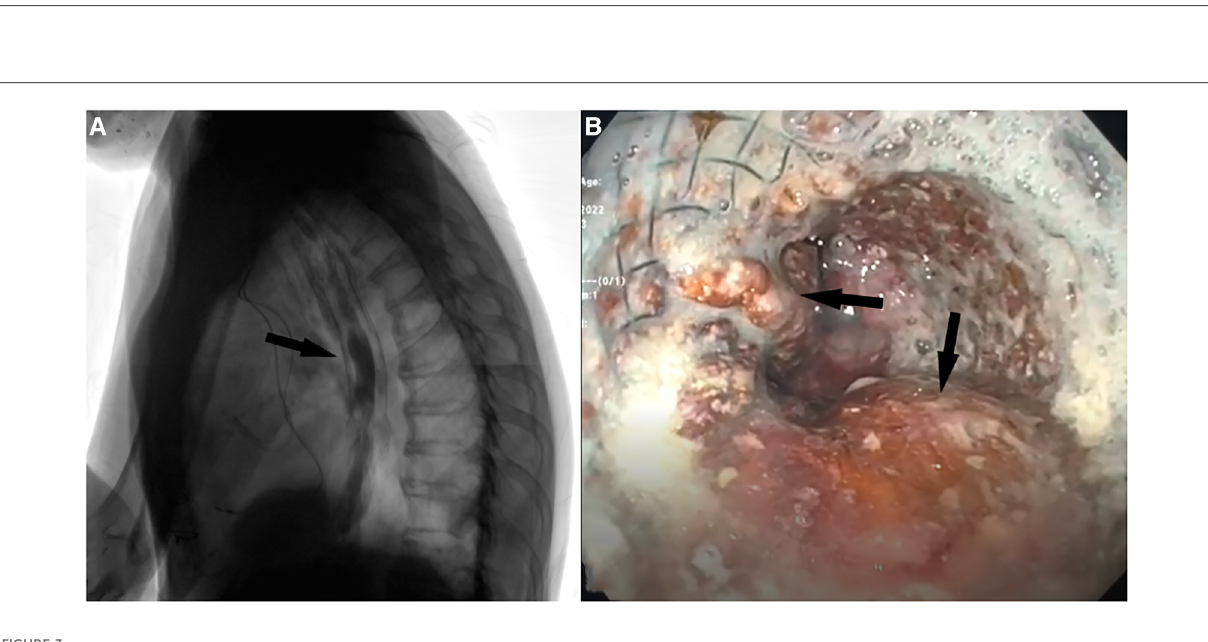
FIGURE 3 ( A ) Postoperative barium video fl uoroscopy showing contrast medium passing regularly passing through the esophagus without signs of aspiration through the site of TEF. ( B ) EGDS performed after 7 months showing esophageal stent in place with fascia lata adipose tissue inside interstices (black arrows).